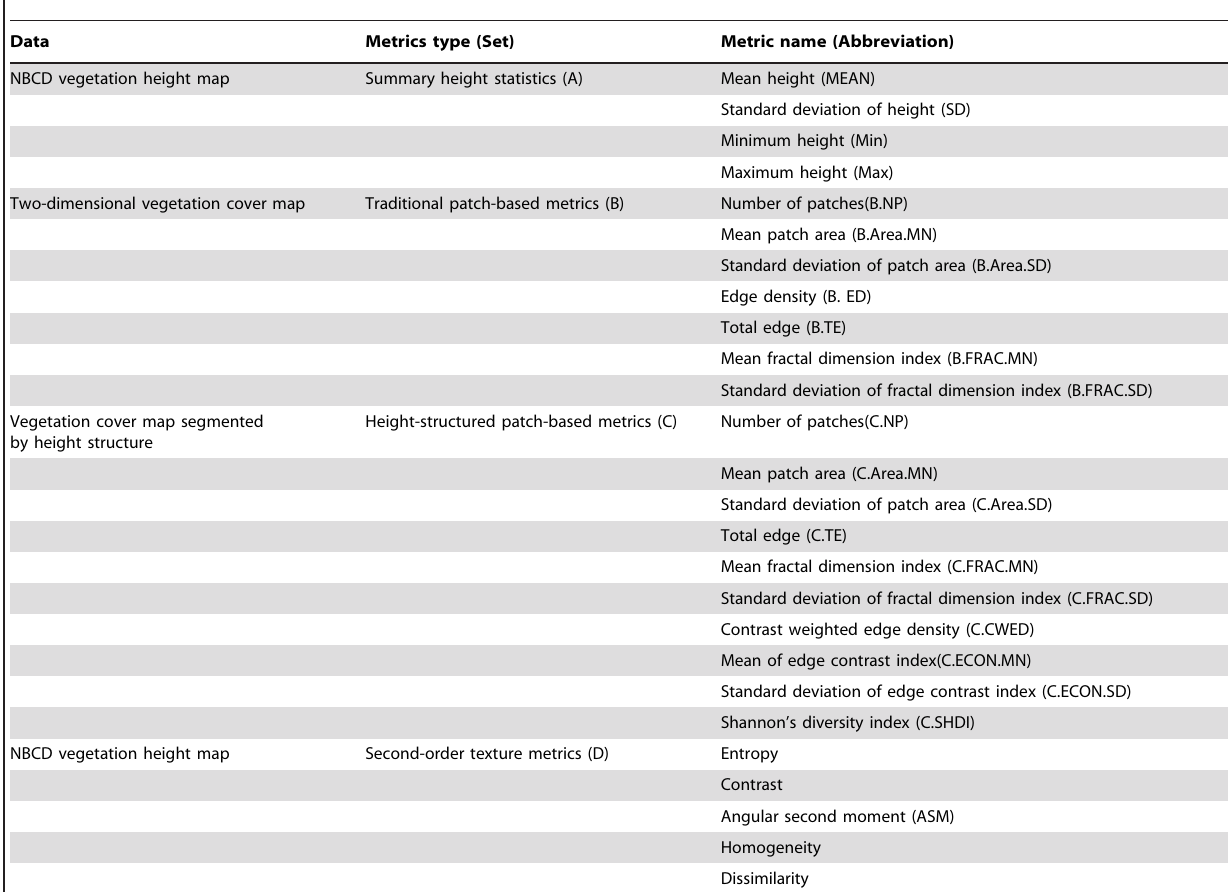
Table 1. List of all metrics developed in the